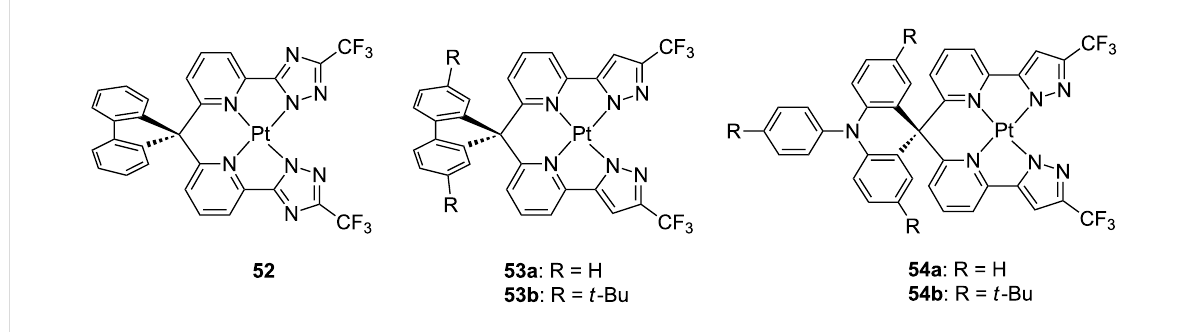
Figure 22: Molecular structure of the pyridylazolate-based complexes 52 – 54 reported by Chi and co-workers